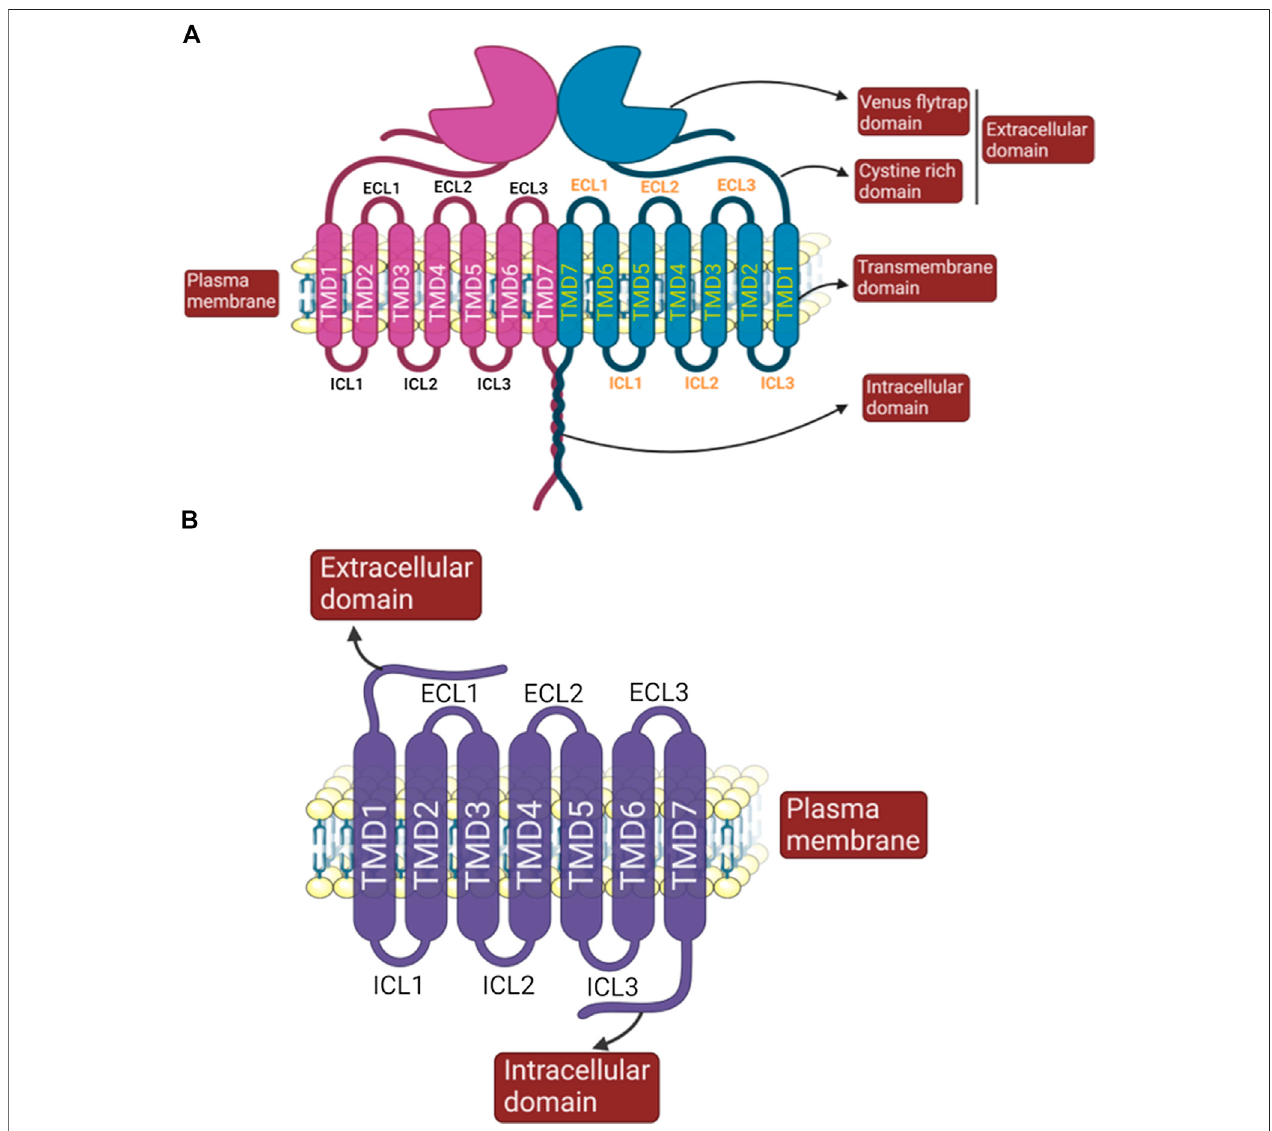
FIGURE 4 | Figure depicting basic structural features of sweet/umami/kokumi dimeric receptor (A) and monomeric bitter receptor (B) (created with BioRender. com).